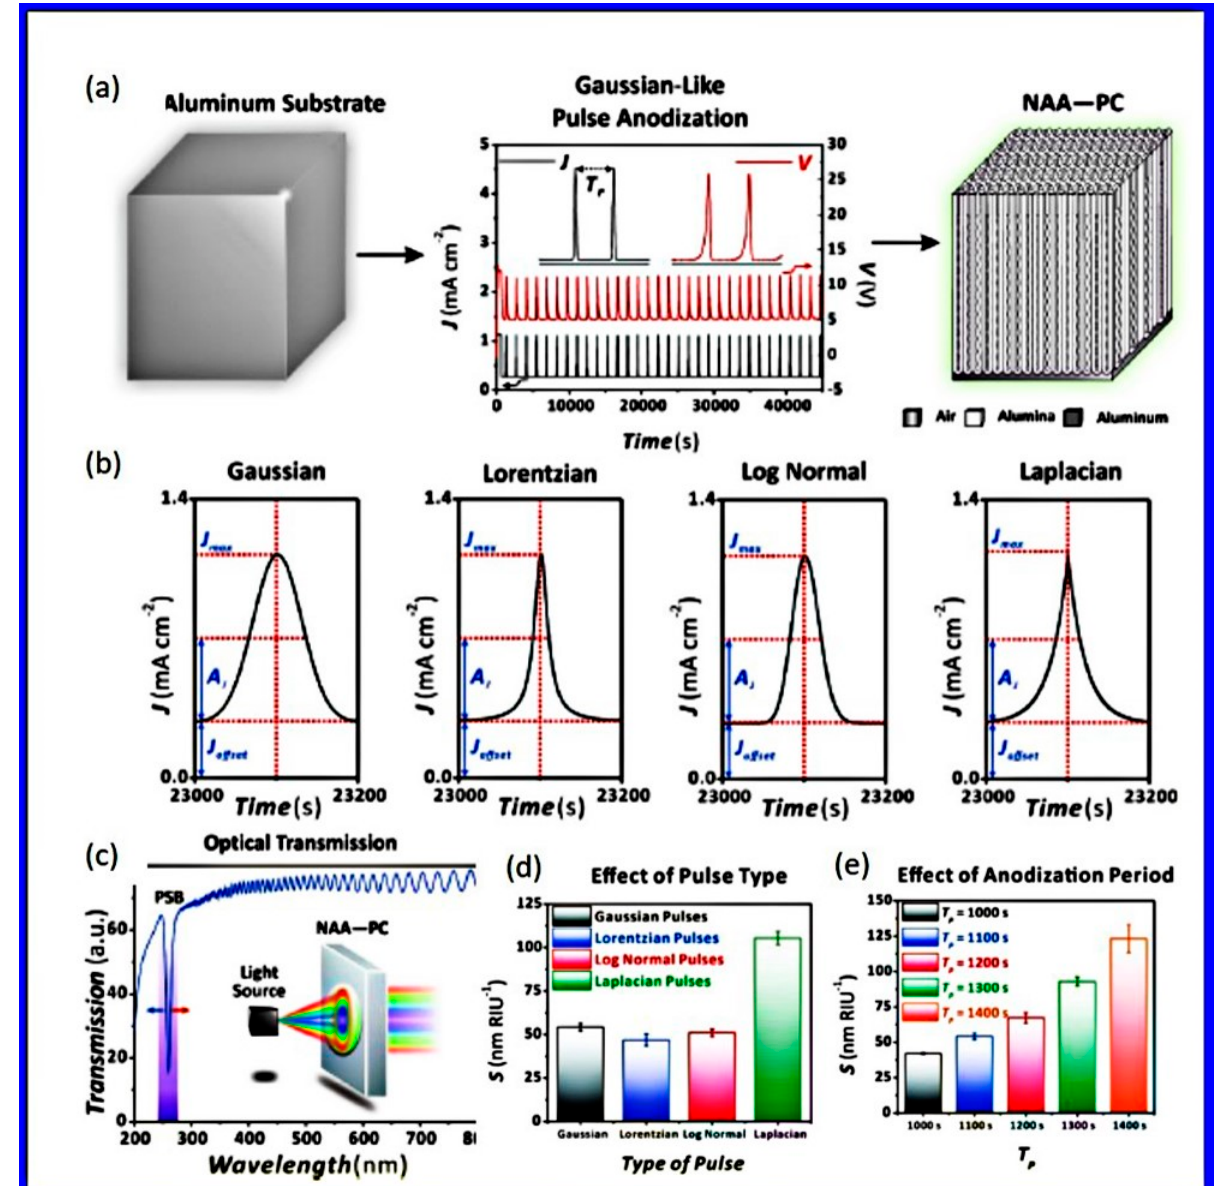
Figure 13. ( a ) Preparation and optical engineering of NAA based photonic crystals by pulse anodization; ( b ) four different input current density pulses used for the fabrication; ( c ) a typical UV—Visible transmission spectrum showing the photonic stopband, the inset shows the schematic of NAA based photonic crystal in action; ( d ) comparison of all four types of pulses for the sensitivity and ( e ) effect of anodization period on the sensitivity Reproduced with permission from Lina Liu, Siew Yee Lim, Cheryl Suwen Law, Laura K. Acosta, Bo Jin, Andrew D. Abell, Lluis F. Marsal, Gang Ni, and Abel Santos, Microporous and Mesoporous Materials 312, 110,770 (2021). Copyright 2021 Elsevier [289].